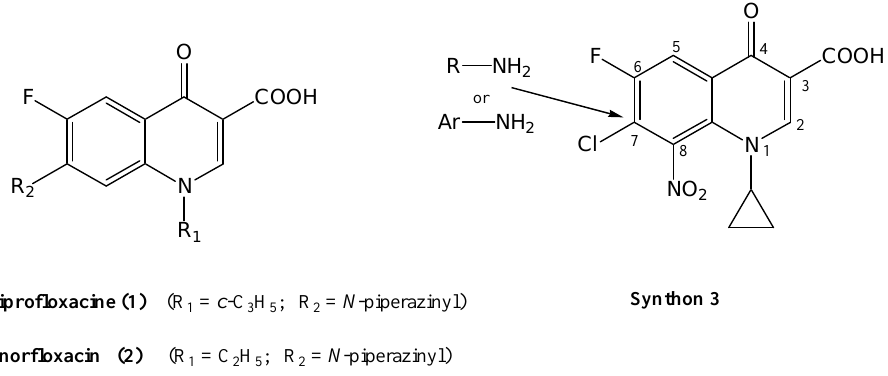
Figure 1. General route for introducing substituted primary amine